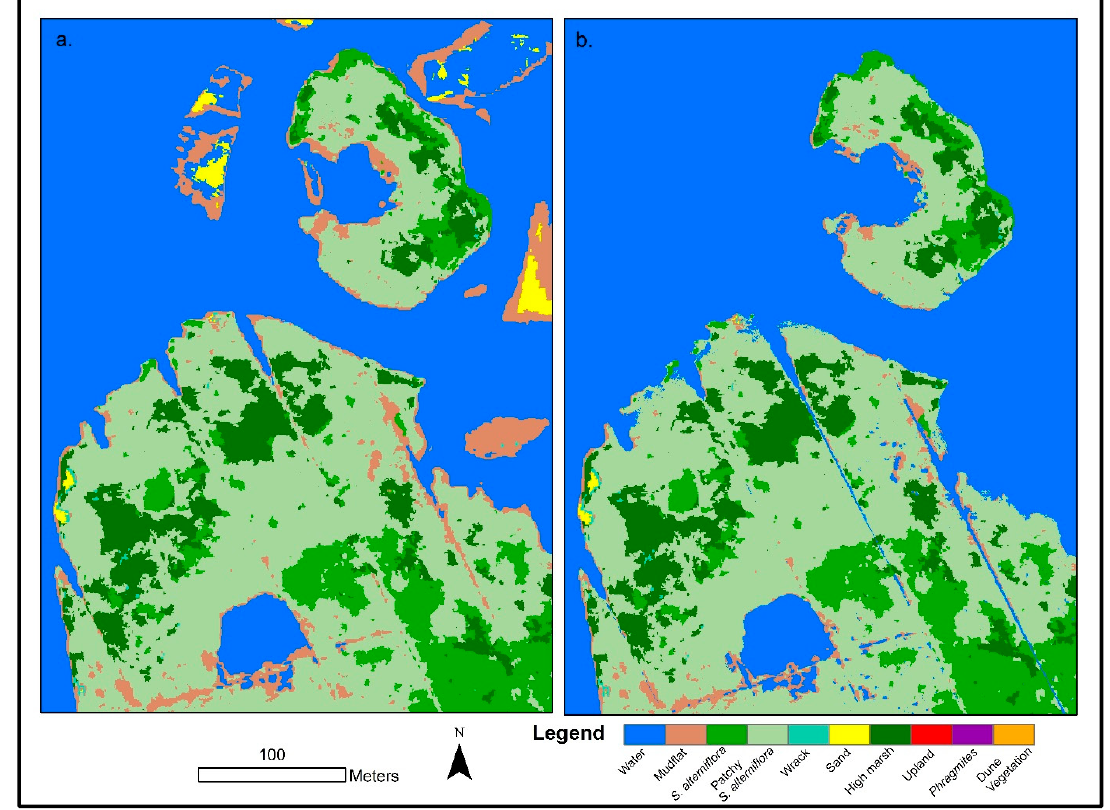
Figure 4. ( a ) The 2015 Worldview-2 and Worldview-3 Classification for a section of Fire Island east of the breach. ( b ) The modeled tidal inundation of the 2015 classification at a tidal stage of 14.3 cm above NAVD 88, which corresponded to the highest tidal stage of the imagery used in the study.